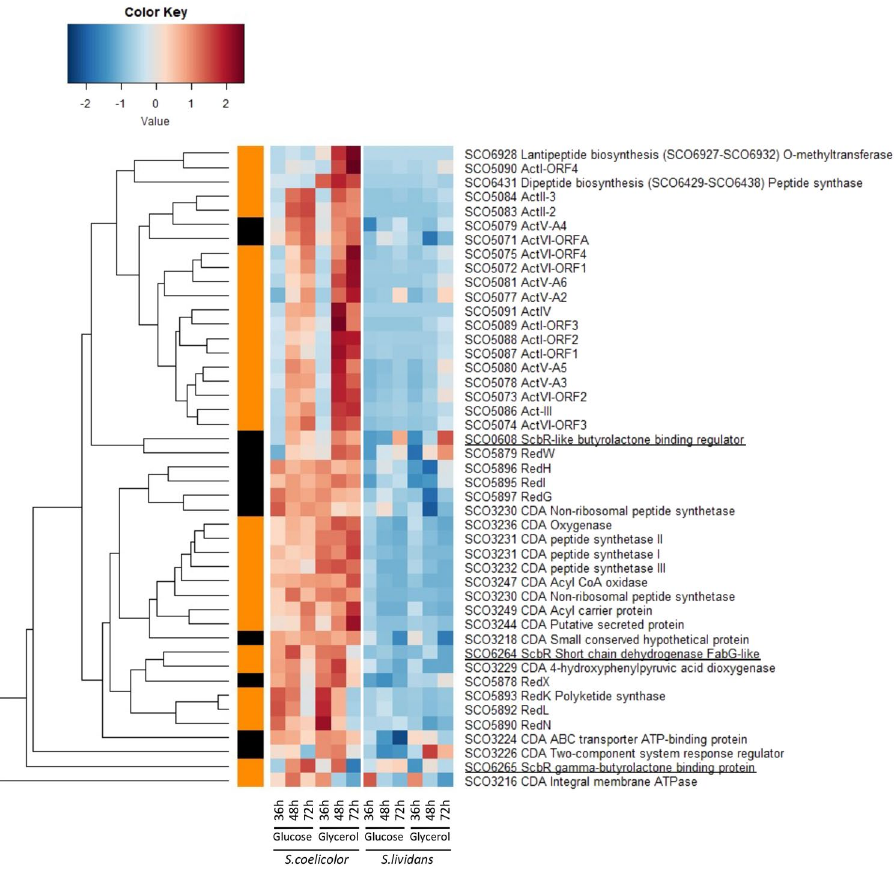
Figure 9. Heatmap representation of proteins belonging to Calcium Dependent Antibiotic (CDA), Red- pigmented cell-associated undecylprodigiosin (RED) and Actinorhodin (ACT) pathways with significant abundance change (ANOVA, adjusted p value < 0.05) between S. coelicolor (M145) and S. lividans (TK24) with either glucose or glycerol as main carbon source, for 36, 48 and 72 h. Protein identifiers are indicated as SCO numbers for both strains and by predicted functions. ScbR proteins are underlined. The quantification methods are displayed in the vertical bar indicating proteins quantified by Spectral Counting (orange) or XIC